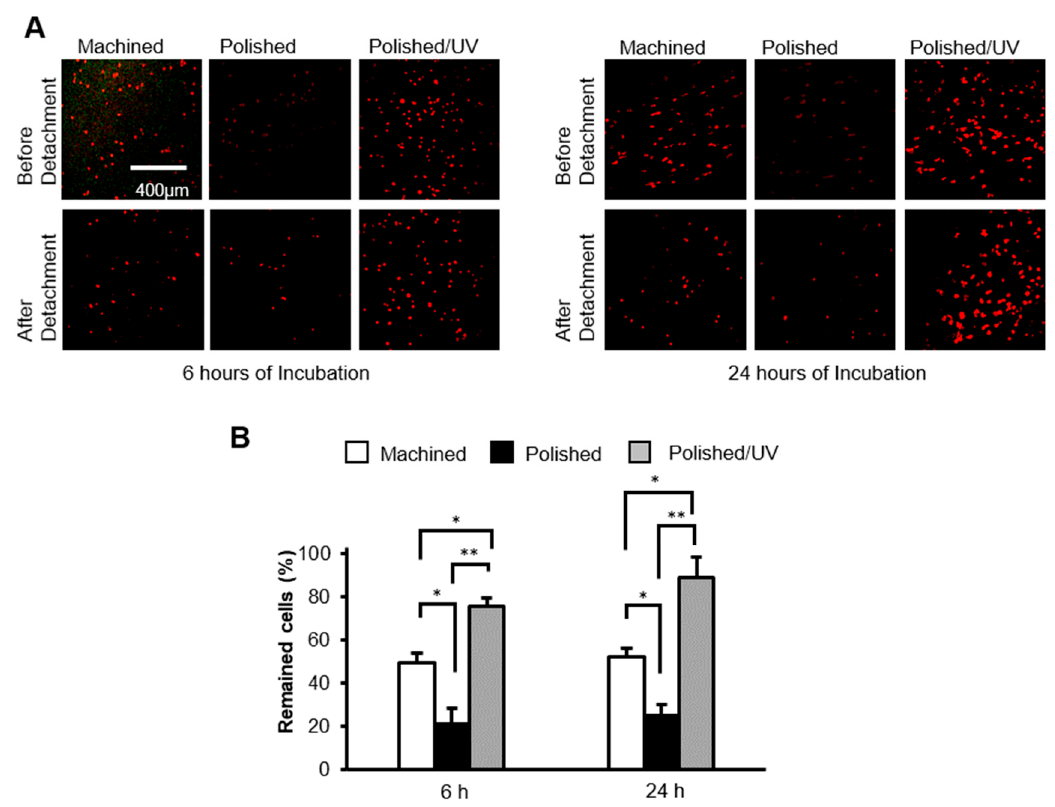
Figure 7. The number of human epithelial cells remaining after mechanical detachment procedures. ( A ) After 6 and 24 h of seeding, confocal microscopy images of human epithelial cell cultures grown on titanium disks. Representative confocal microscopy images of cells stained with rhodamine-phalloidin, for actin filaments (red). Scale bar = 400 µ m. ( B ) The percentages of cells remaining after 6 and 24 h of incubation were determined by using a water-soluble tetrazolium salts (WST-1) assay (* p < 0.05, ** p < 0.01).